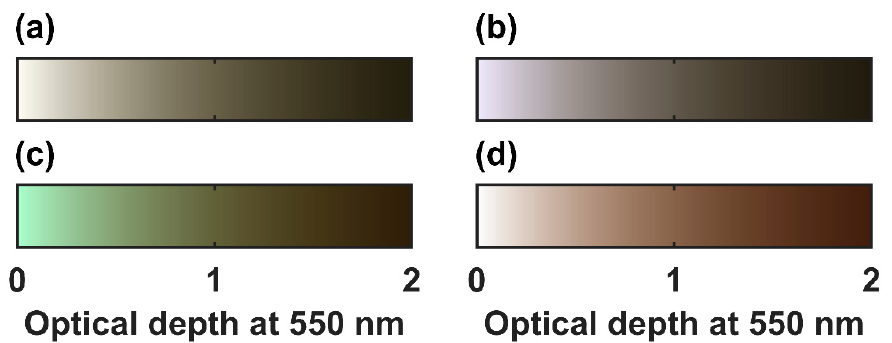
Figure 3. Colors of BC aerosol layers with different optical depths. ( a – d ) are four conditions differing in assumptions of simulation. ( a ) Solar spectrum and eye response. ( b ) Simplified spectrum and eye response. ( c ) Solar spectrum and simplified response. ( d ) Simplified spectrum and simplified response. The simplified spectrum is set to have the same irradiance at each wavelength. The simplified response is set to only have a response at the three wavelengths, 435 nm 550 nm and 700 nm, and the eye can change all light information into color information.